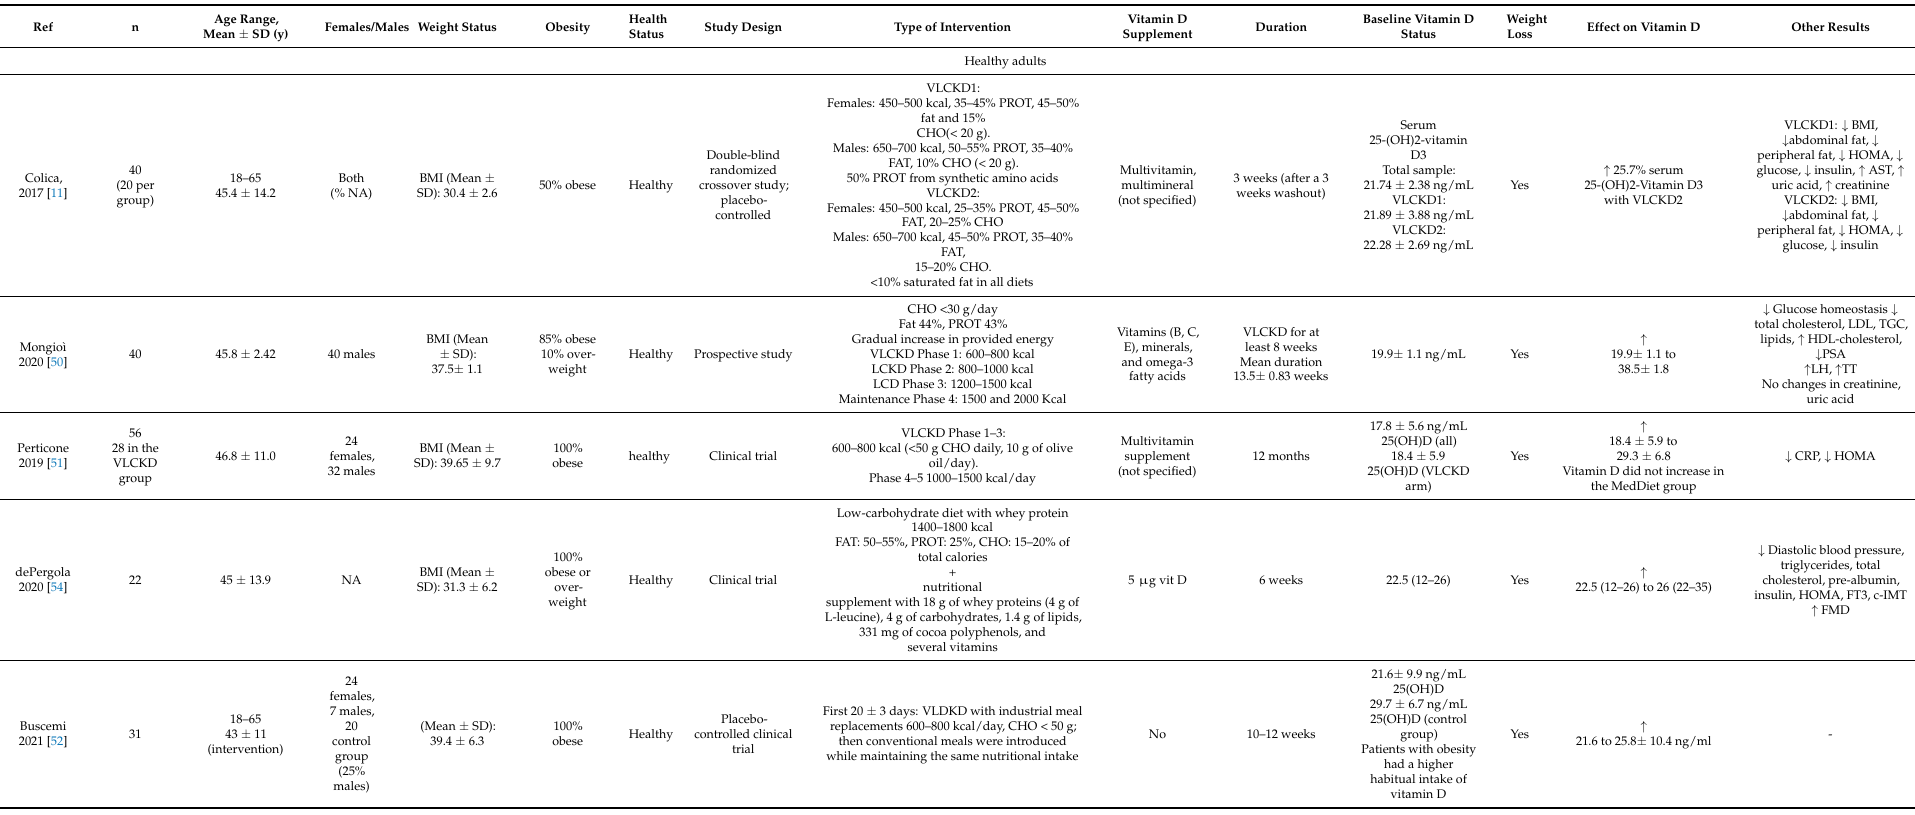
Table 1. Intervention studies with KDs in subjects with overweight, obesity, or T2D diabetes in which vitamin D status was assessed pre- and